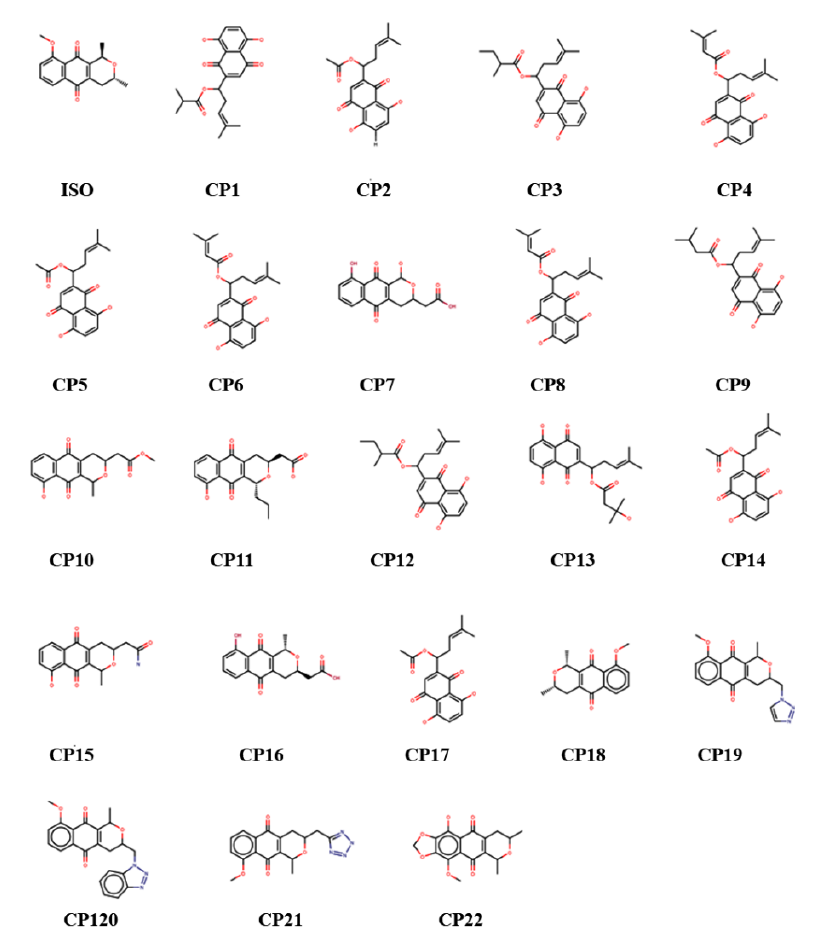
Figure 3. Chemical structure of isoeleutherin and analogues.